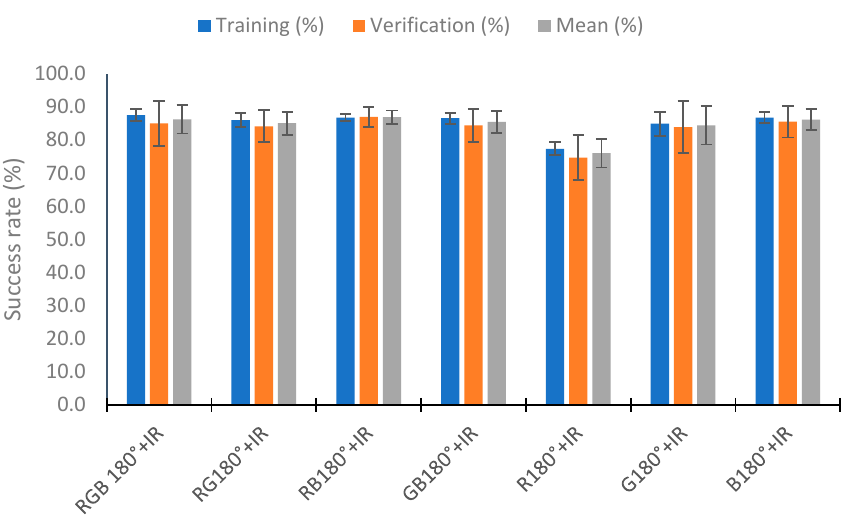
Figure 23. Success rate in the neural network with the data of the different RGB light at 180 ◦ and IR light.